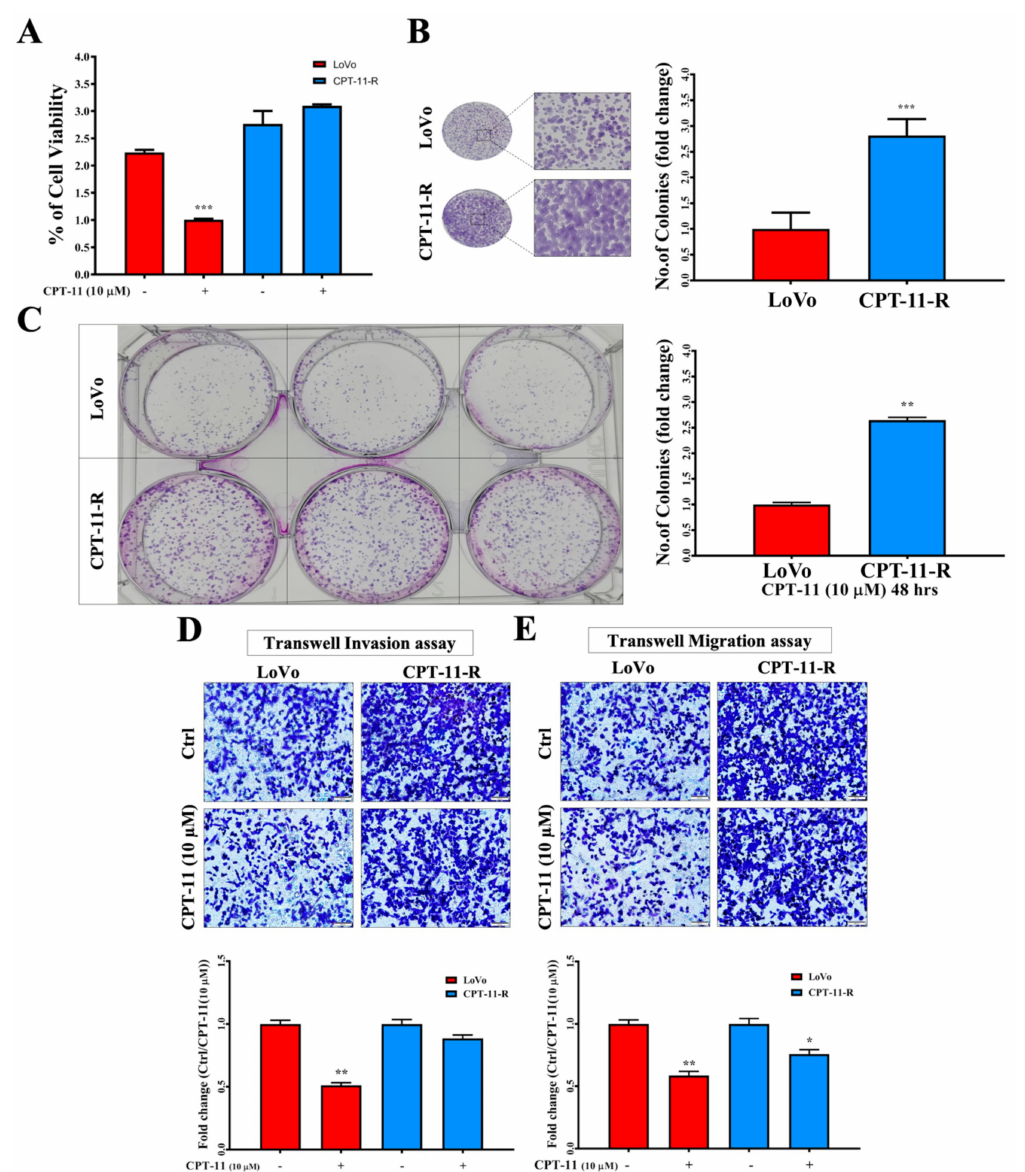
Figure 3. CPT-11-R cells demonstrate enhanced first-line chemoresistance, colony formation, and invasion and migration ability. ( A ) The chemoresistance ability of CPT-11-R cells was determined after 10 µ M CPT-11 drug treatment for 48 h in comparison with LoVo cells. ( B ) The colony formation ability of the CPT-11-R cells was determined without treatment under normal conditions and fold change normalized with untreated control group. ( C ) CPT-11-R cell colony formation ability with 10 µ M CPT-11 treatment. ( D ) Invasion and ( E ) migration assay (scale bar: 100 µ m). The results are presented as mean ± standard error of the mean ( n = 3). * p < 0.05, ** p < 0.01, *** p < 0.001 compared to